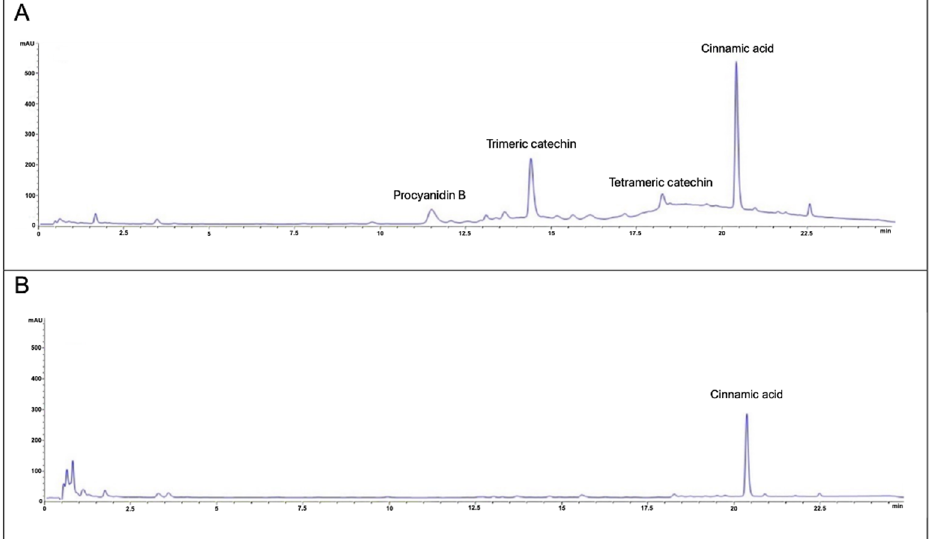
Figure 2. Chromatographic profile of the polyphenol-rich cinnamon bark extract before and after in vitro digestion. The figure represents the chromatograms obtained through HPLC analysis, before ( A ) and after ( B ) in vitro enzymatic digestion.